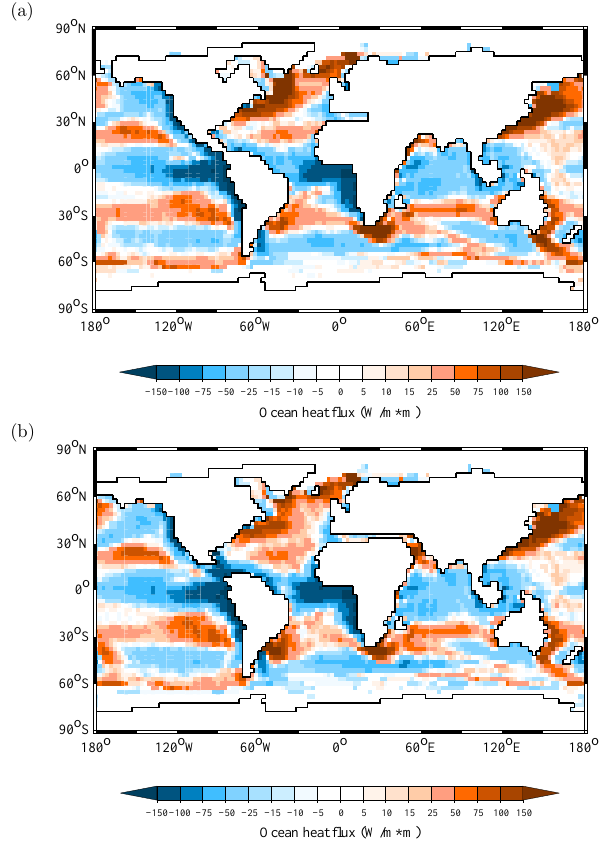
Fig. 3. Land-sea mask and topography on land for (a) the CTRL configuration and (b) the Miocene